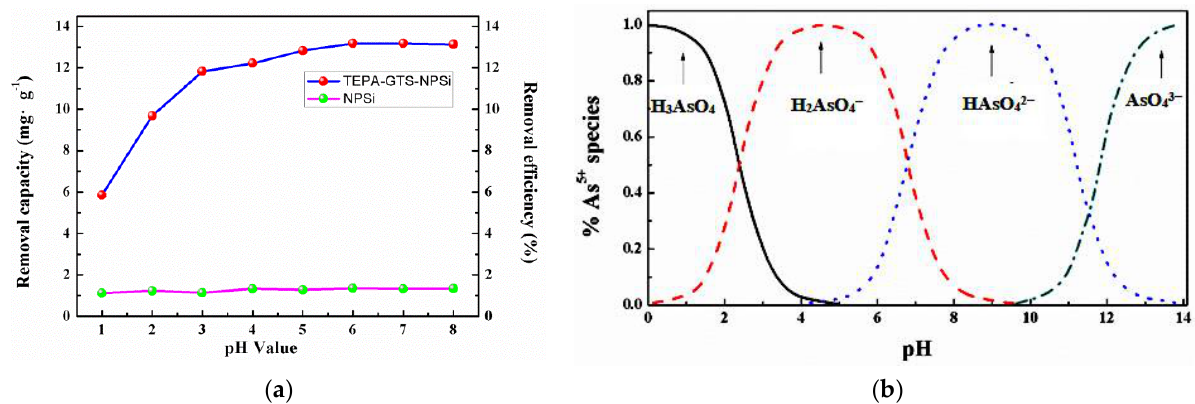
Figure 4. Effect of initial pH on As(V) adsorption ( a ) and species of As(V) with a range of solution pH ( b ).